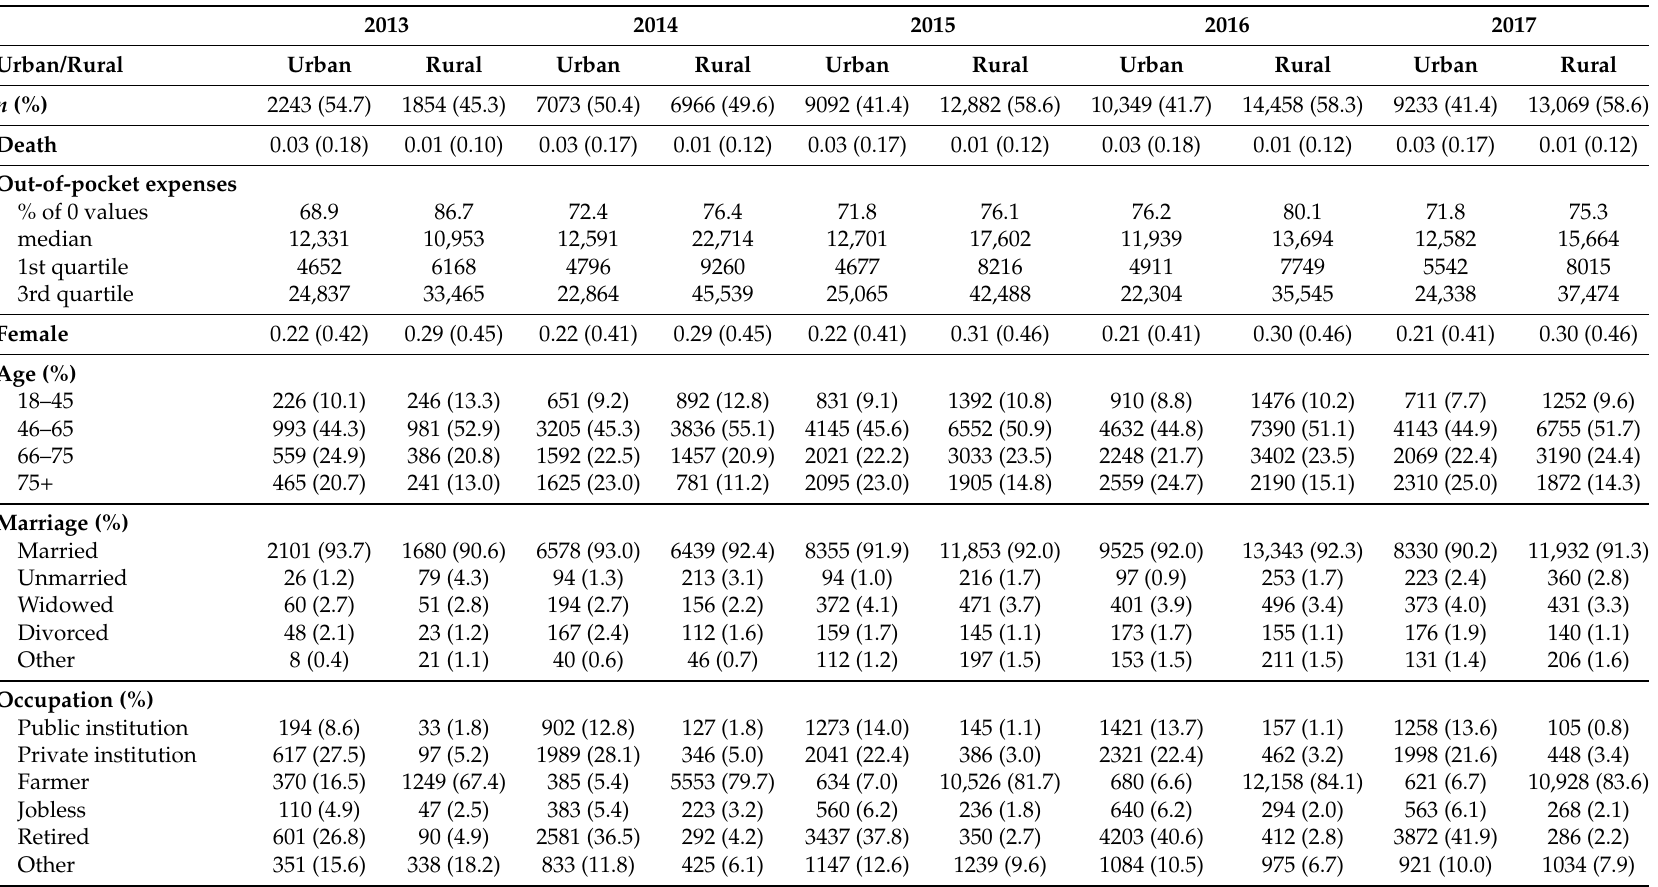
Table 1. Descriptive statistics of sample acute myocardial infarction patient characteristics,